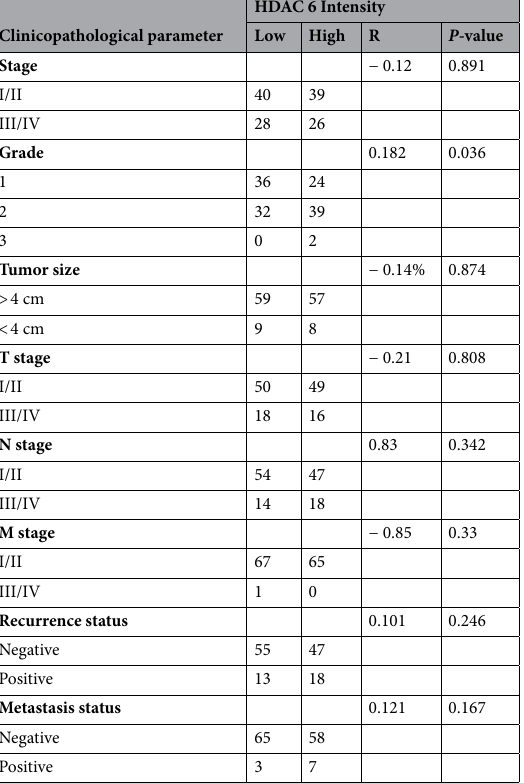
Table 2. Relationship between the HDAC6 intensity level and clinicopathologic parameters of patients with OSCC.